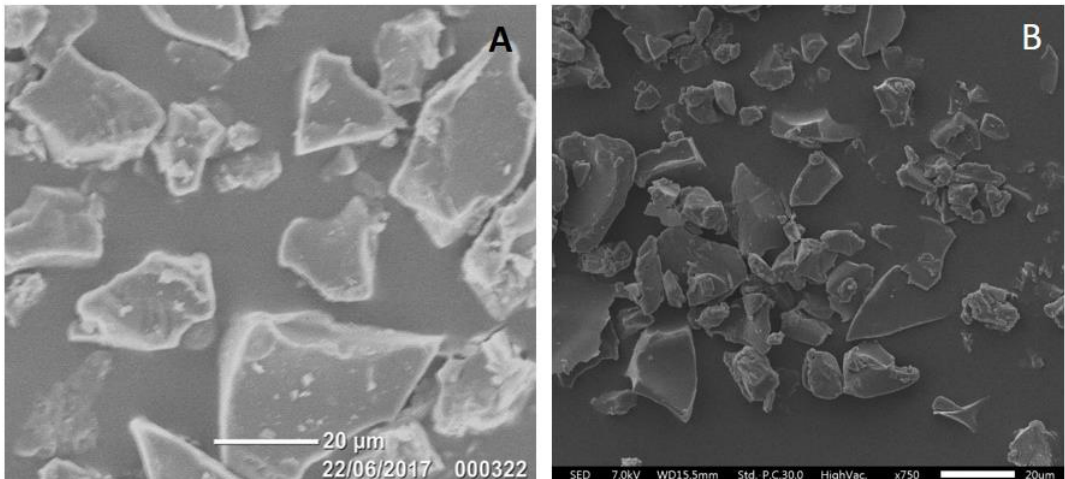
Figure 5 . SEM micrographs illustrating the morphology and size of sustained-release ketamine-loaded microparticles (Formulation 6: 10% Ketamine + 90% PLGA5050-1.5E) stored at 2–8 °C for one month ( A ) and 6 months ( B ).